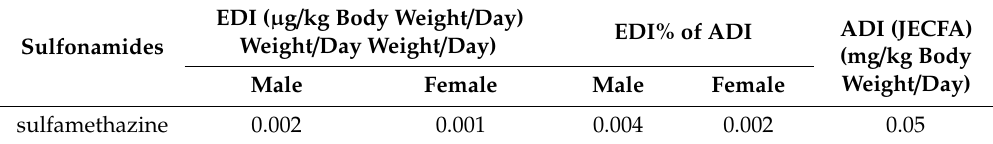
Table 3. Estimated daily intake (EDI) levels of sulfonamide residues in Taiwanese adults.